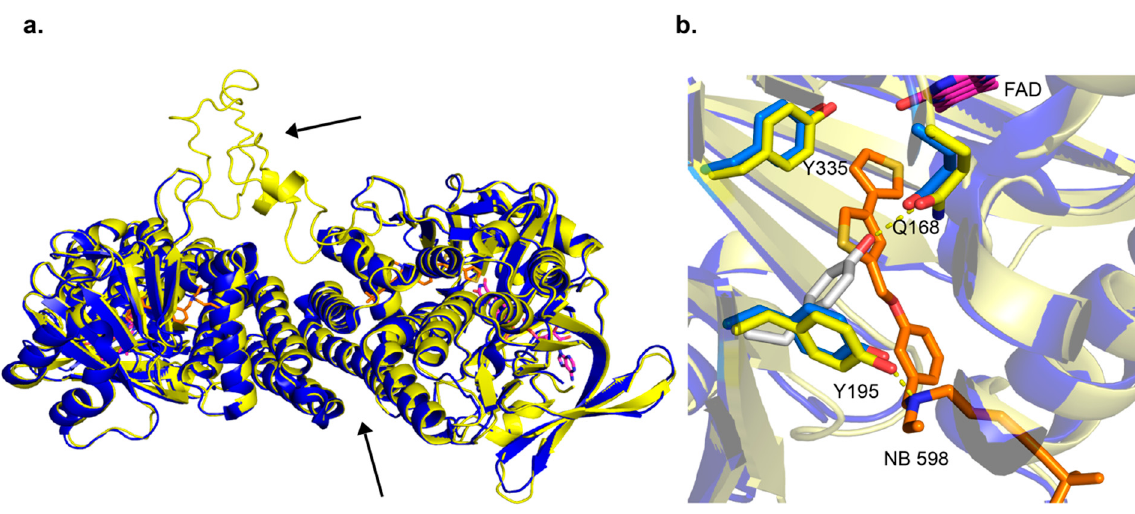
Figure 3. Overlay of human SM X-ray crystal structure and the S. cerevisiae Erg1 homology model. The homology model was downloaded from SWISS-MODEL with PDB ID 6C6N used as a template [60]. The ScErg1 is in yellow and SM (PDB ID 6C6P) is in blue. FAD and NB-598 are represented with sticks with carbons colored magenta and orange, respectively. ( a ) Two molecules were found in the asymmetric unit and the interface of C-terminal α -helices is indicated with an arrow. The extended loop of ScErg1 is shown with an arrow. ( b ) The residues Q168, Y195, and Y335 (Q63, Y90, and Y261, S. cerevisiae numbering) are shown as sticks. In gray is the Y195 residue position in the absence of the inhibitor (PDB ID 6C6R). The hydrogen bonds are shown as yellow dashed lines.